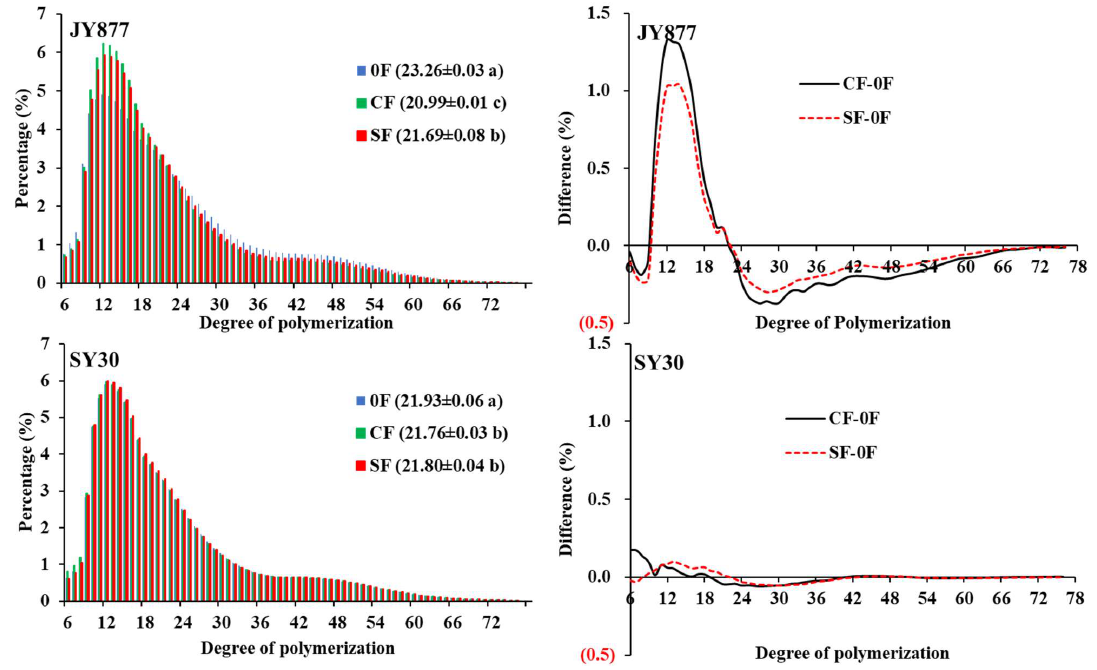
Figure 3. Effects of the fertilization mode on isoamylase-debranched amylopectin chain length distribution of normal maize. The data in brackets are the average chain length. Mean values within the same hybrid followed by different letters are significantly different at p < 0.05. JY877, Jiangyu877; SY30, Suyu30; 0F, zero fertilization; CF, common fertilization; SF, slow-release